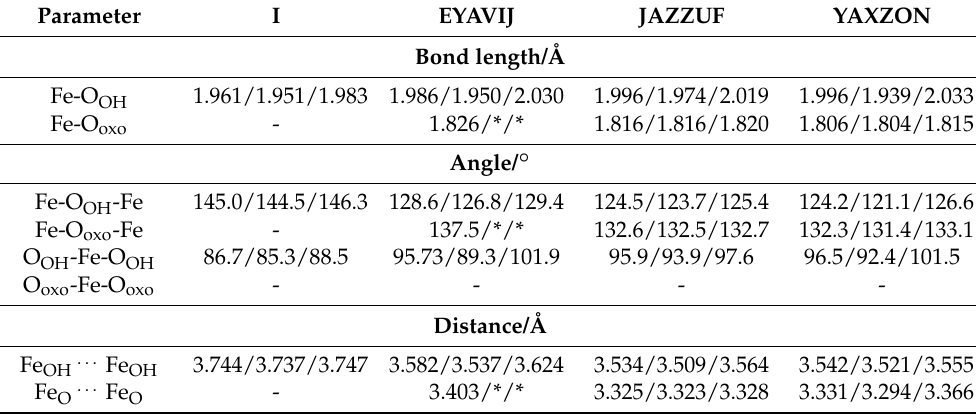
Table 4. The geometrical parameters characterizing Fe adamantane-like structures containing oxo (O oxo ) and hydroxo (O OH ) bridging oxygen atoms. Fe O ... Fe O —oxo mediated Fe ... Fe